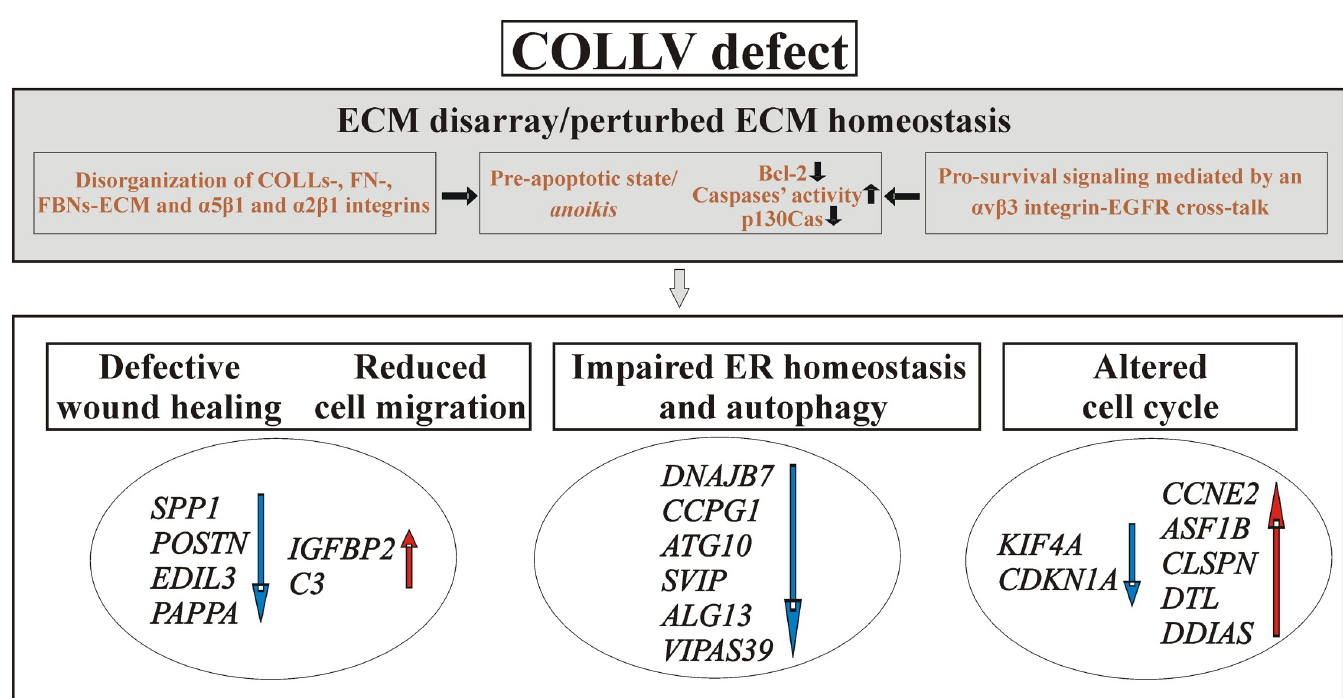
Fig 5. Schematic summary illustrating the main biological processes deregulated in skin fibroblasts with COL5A1 and COL5A2 pathogenetic variants. COLLV defect is associated with pathological ECM remodeling and anoikis , which is rescued by an α v β 3 integrin-EGFR signaling transduction pathway [20], together with defective ER homeostasis, autophagy and cell cycle progression. Down-regulated DEGs are indicated by blue arrows and those up-regulated by red